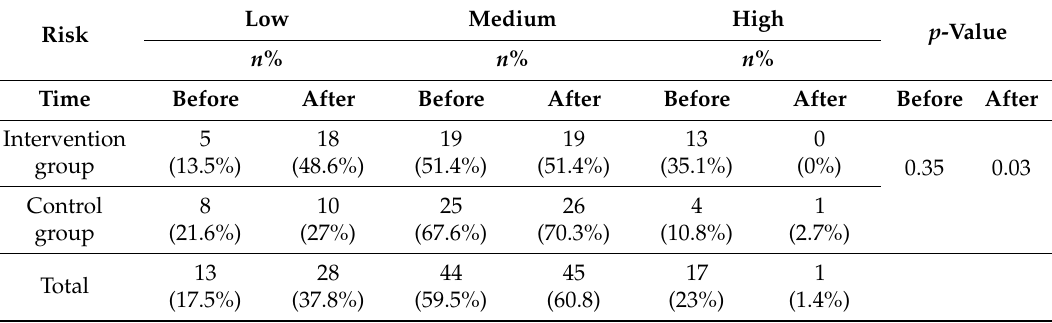
Table 5. The risk of developing MSDs before and after the intervention in the groups.